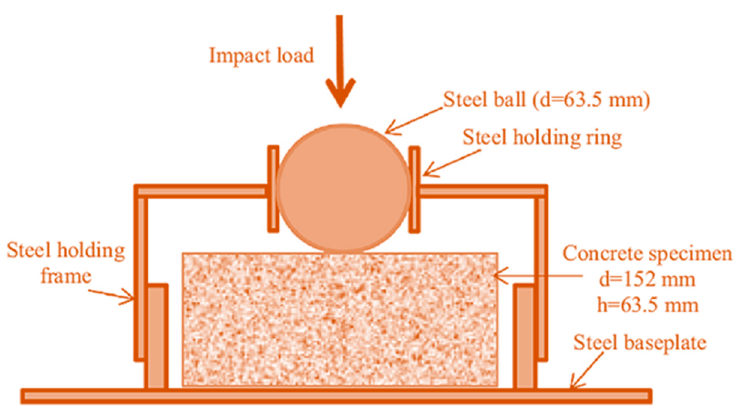
Figure 1. A drop weight impact test suggested by ACI 544.